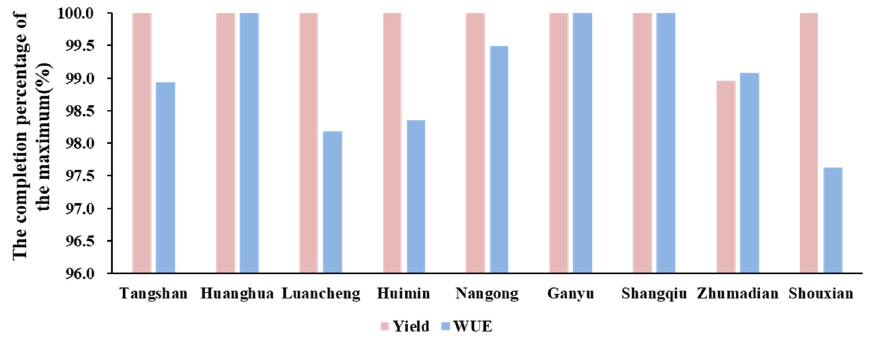
Figure 4. The completion percentage of the maximum yield and water use efficiency (WUE) based on the OI t .